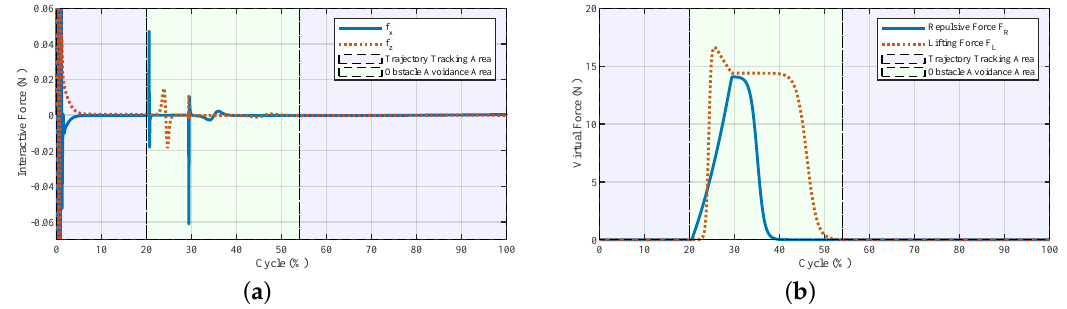
Figure 3. Interactive forces and the virtual forces of the system generated during stepping over the obstacle. ( a ) Human–exoskeleton interactive forces and ( b ) repulsive force and lifting force.